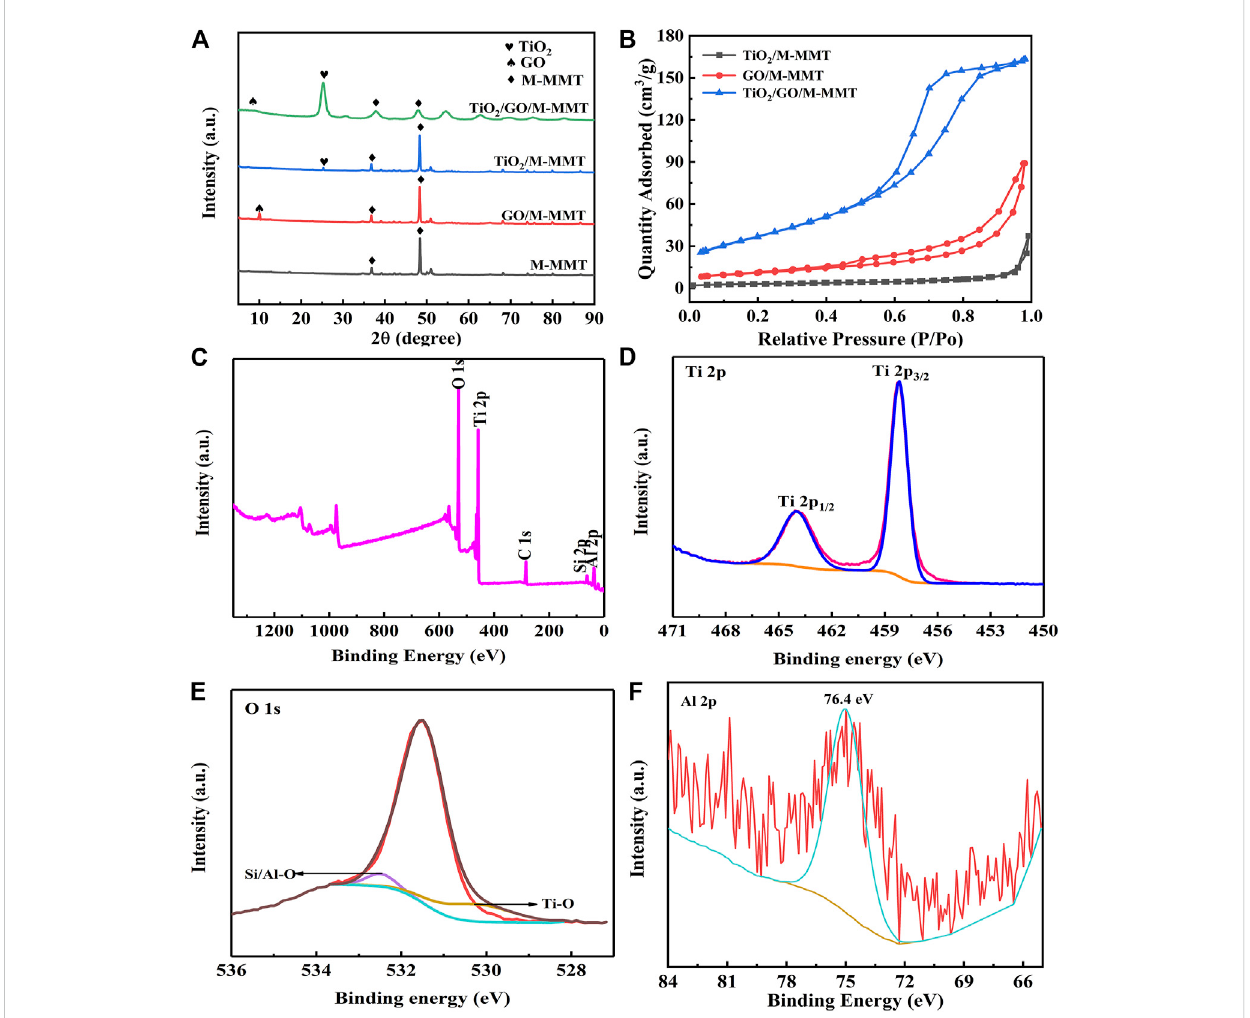
FIGURE 3 (A) X-ray diffraction patterns of different specimen with M-MMT, GO/M-MMT, TiO 2 /M-MMT and TiO 2 /GO/M-MMT; (B) Nitrogen adsorption and desorptioncurveofdifferentnanocomposite; (C)